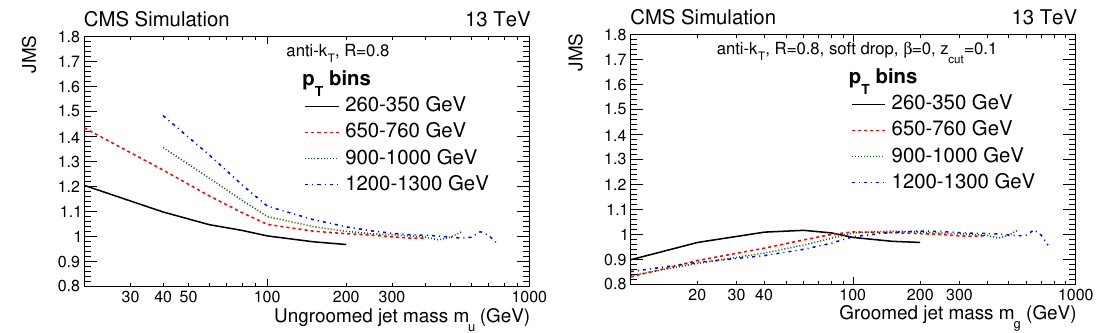
Figure 1 . JMS in simulation (mean of a (cid:12)t to m reco =m gen ) for ungroomed (left) and groomed (right) jets in di(cid:11)erent generated p T bins, as a function of the generated mass, with our